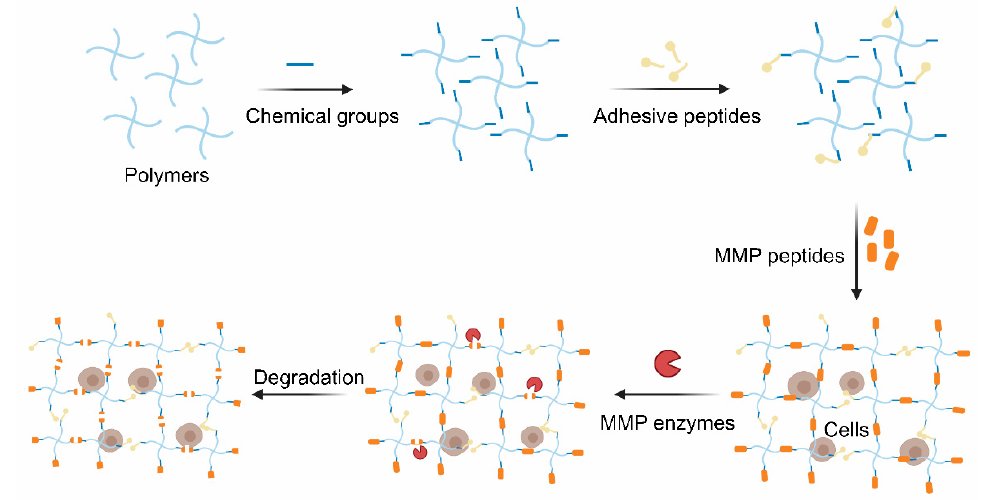
Figure 3. Preparation and degradation of MMP-cleavable peptides-based hydrogels.